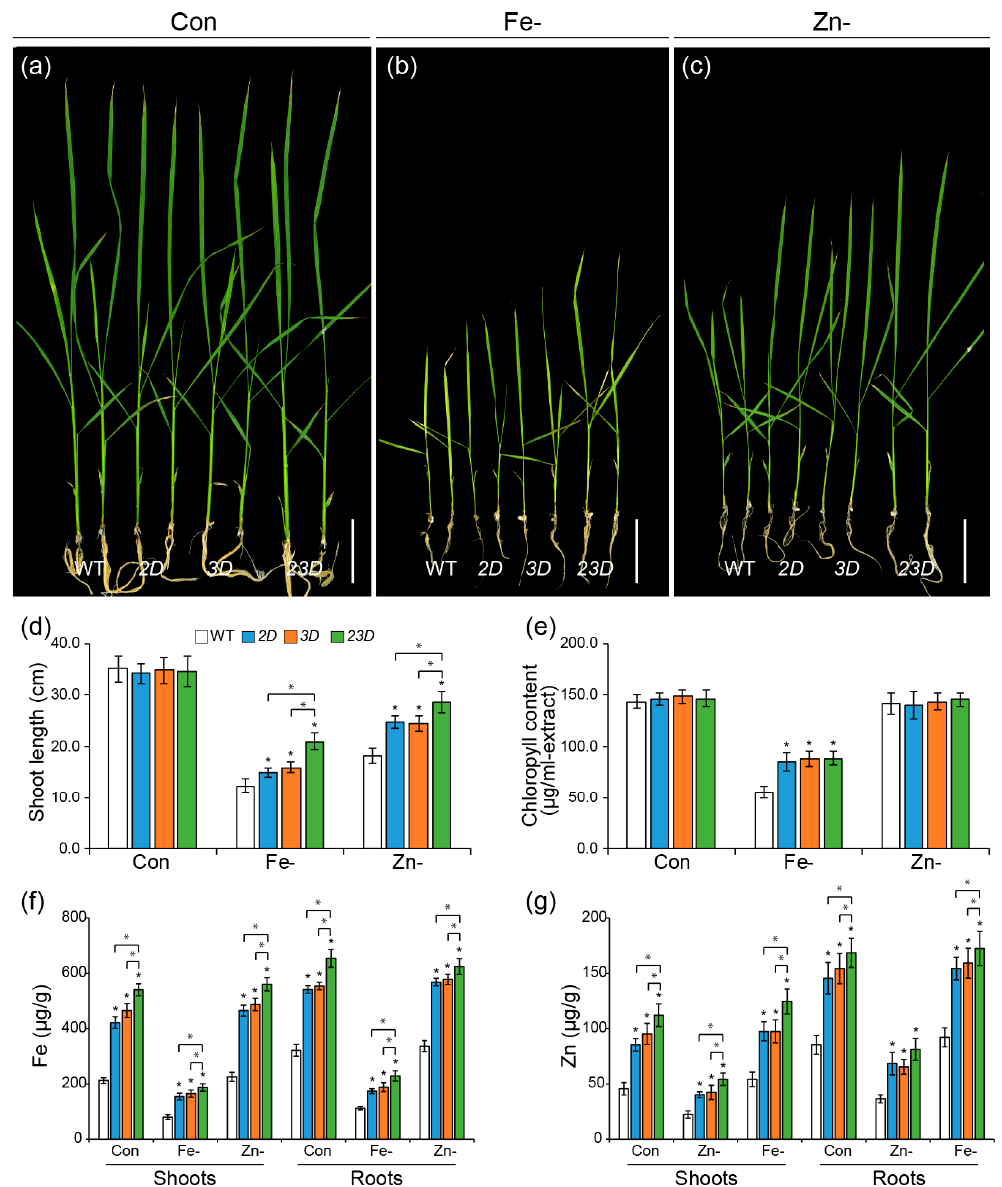
Figure 1. Tolerance of WT and activation-tagged mutants to Fe and Zn deficiencies. ( a – c ) Phenotypes of WT, OsNAS2 activating-tagged mutant ( 2D ), OsNAS3 activating-tagged mutant ( 3D ), and double activation-tagged mutant ( 23D ) grown under control Yoshida solution (Con), Fe-deficient (Fe-) solution or Zn-deficient (Zn-) solution for 15 days. Bars = 5 cm. Shoot lengths ( d ), total chlorophyll concentrations ( e ), Fe concentrations ( f ), and Zn concentrations ( g ) in shoots and roots of WT and activation-tagged mutants. Data are mean ± SE (n = 10 for length; n = 4 for measurements of chlorophyll contents and Fe and Zn concentrations in shoots and roots). Significant differences among WT and mutant plants are indicated with an asterisk (* p < 0.05 by Student’s t -test).